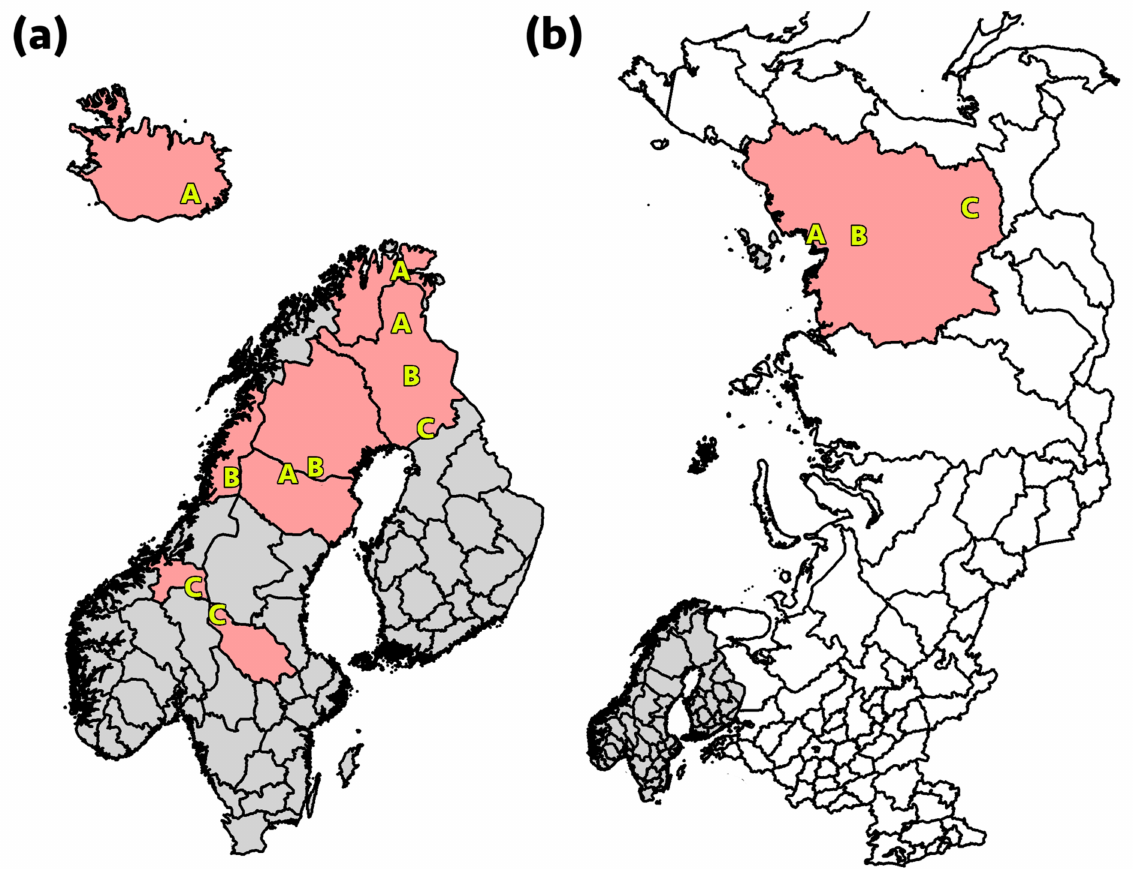
Figure 1. ( a ) In Finland, Norway, and Sweden, samples were collected from three geographical locations, denoted A, B, and C, reflecting different pasture and herding conditions. The sampling region in Iceland is also displayed (A). ( b ) The sampling regions in Ust-Yansky, northern Yakutia (A), Eveno-Bytantay, north-central Yakutia (B), and Aldan, southern Yakutia (C),